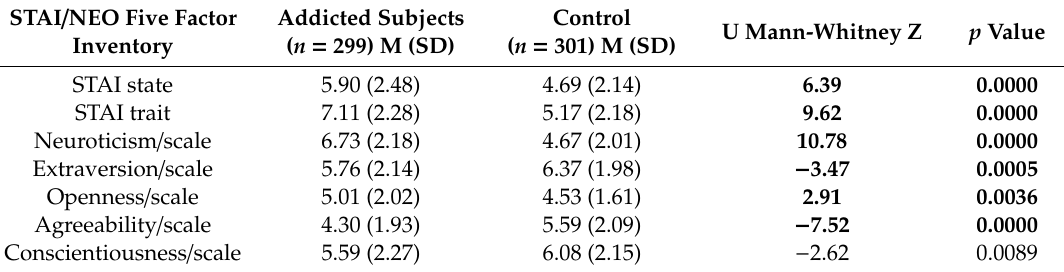
Table 2. STAI and NEO Five Factor Inventory results in group of addicted subjects and in